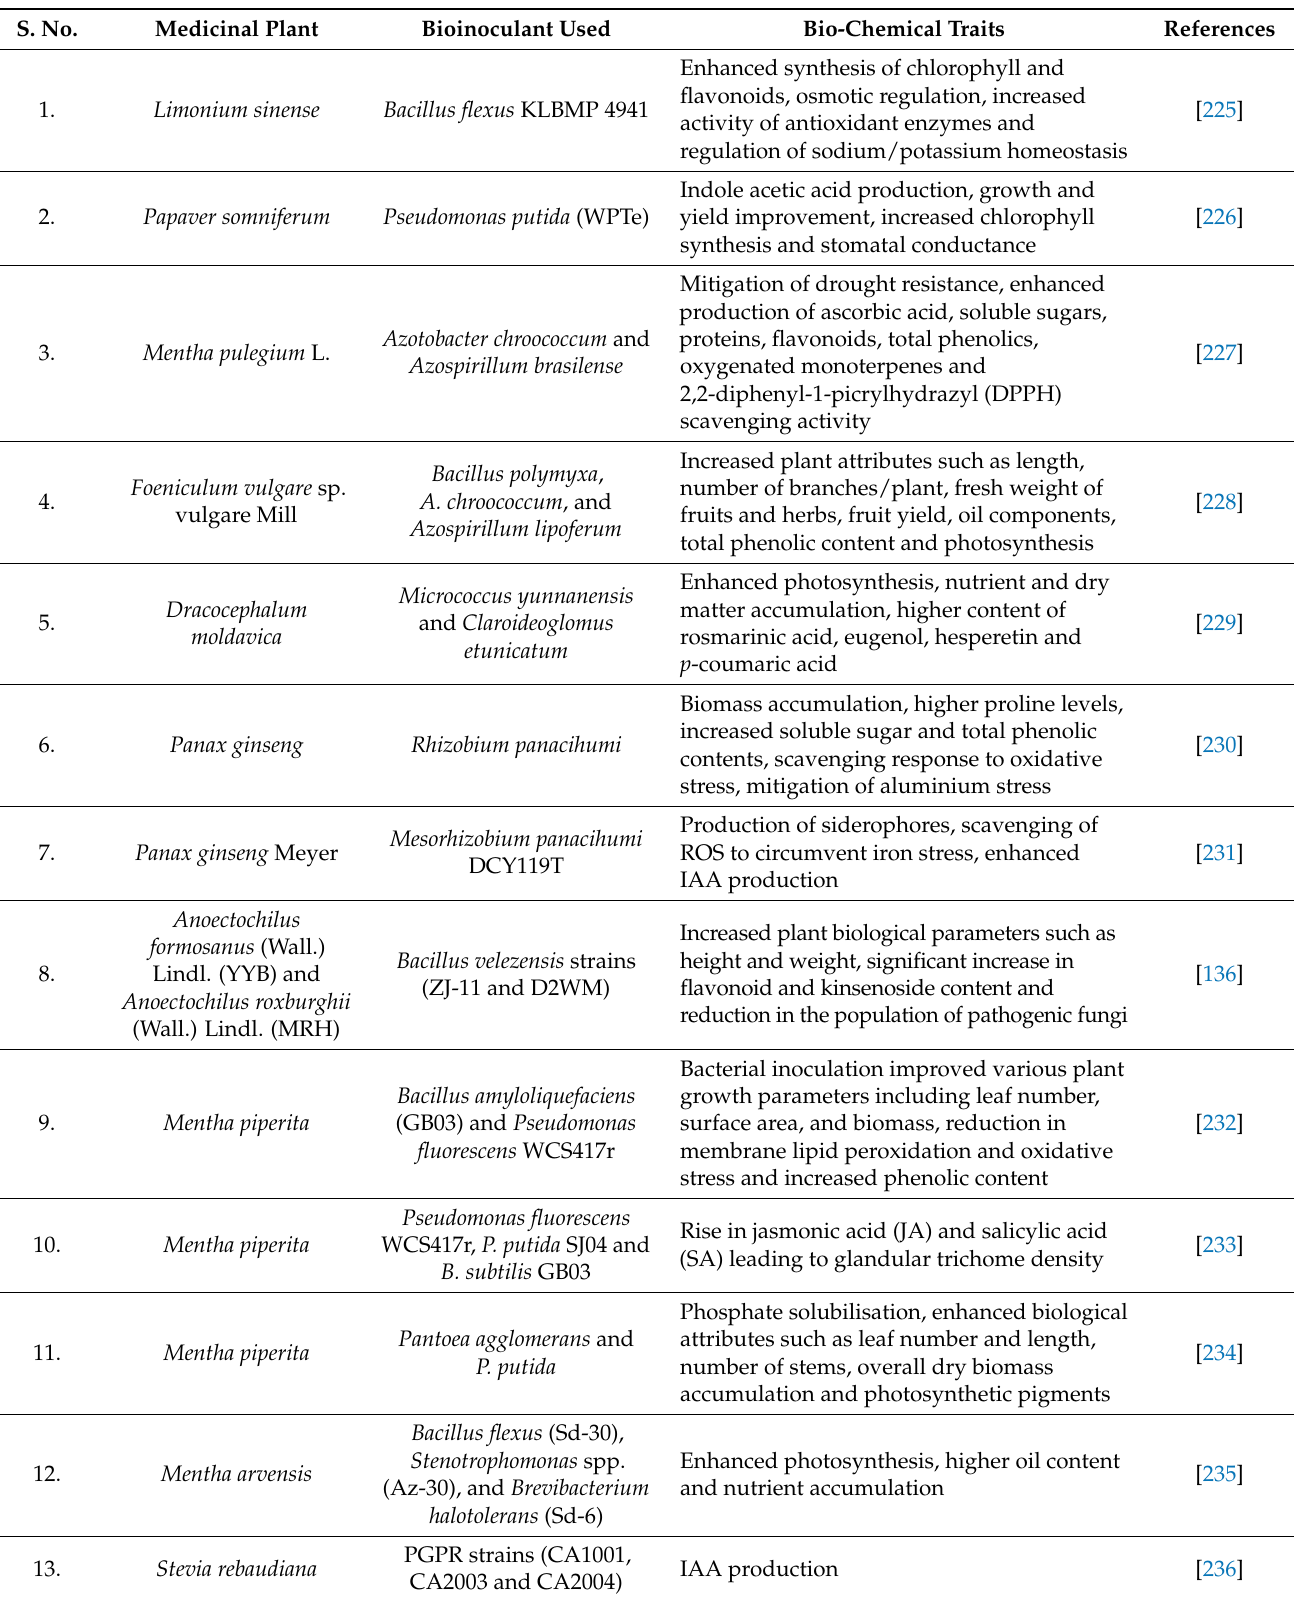
Table 2. Impact of plant growth promoting rhizobacteria on bio-chemical properties and yield of selected medicinal